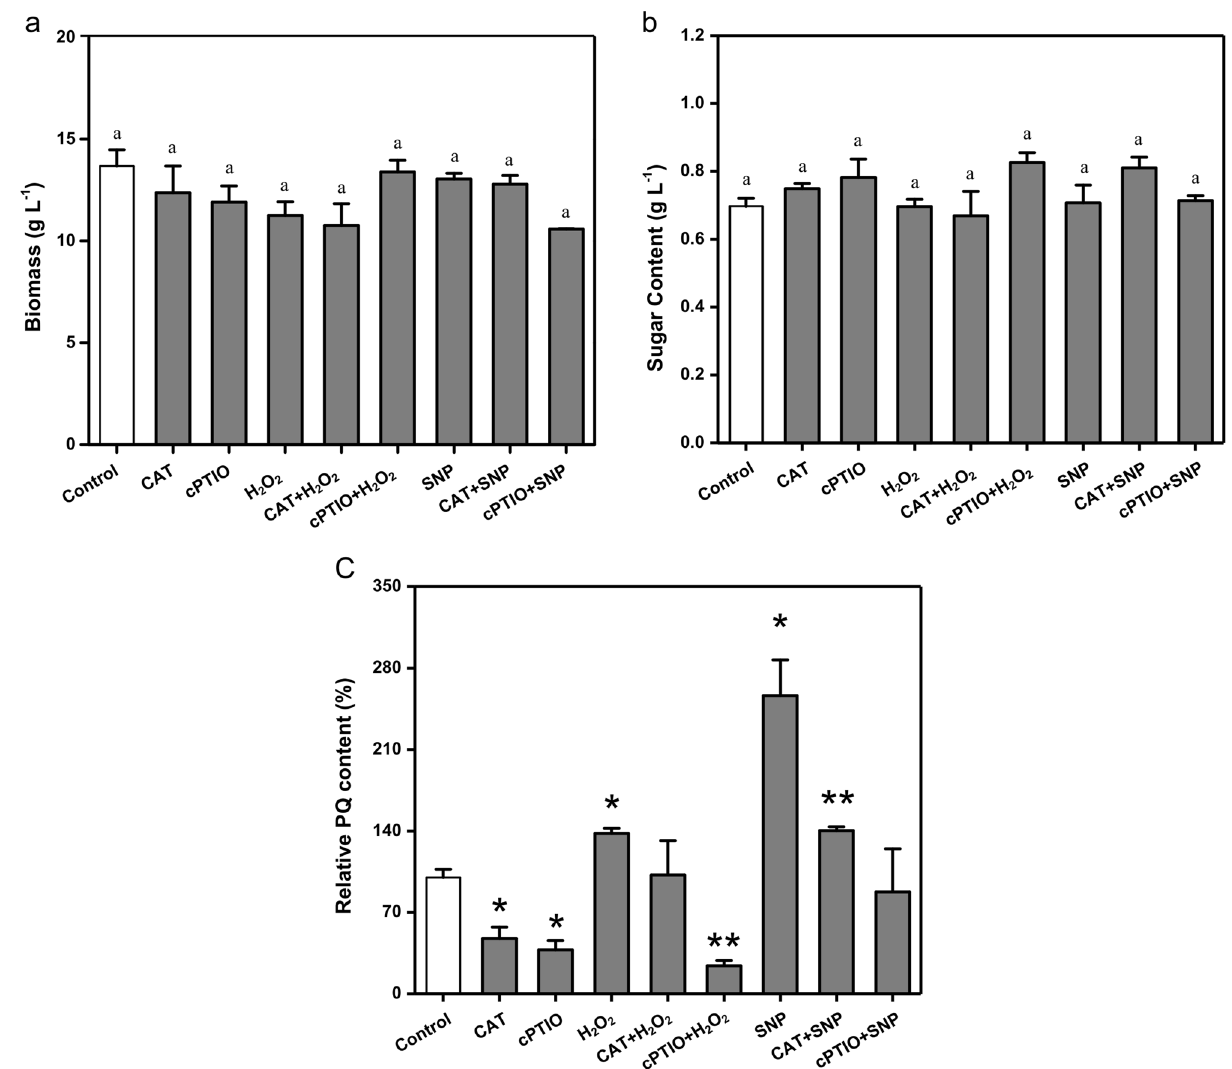
Figure 4. Interactions between H 2 O 2 and NO signaling pathways in Shiraia bambusicola S4201. ( a ) Biomass; ( b ) Sugar content; ( c ) Perylenequinones content. Values are the means of five independent experiments ± SE. Different letters and asterisks on the histogram indicate significant differences between treatments ( p <